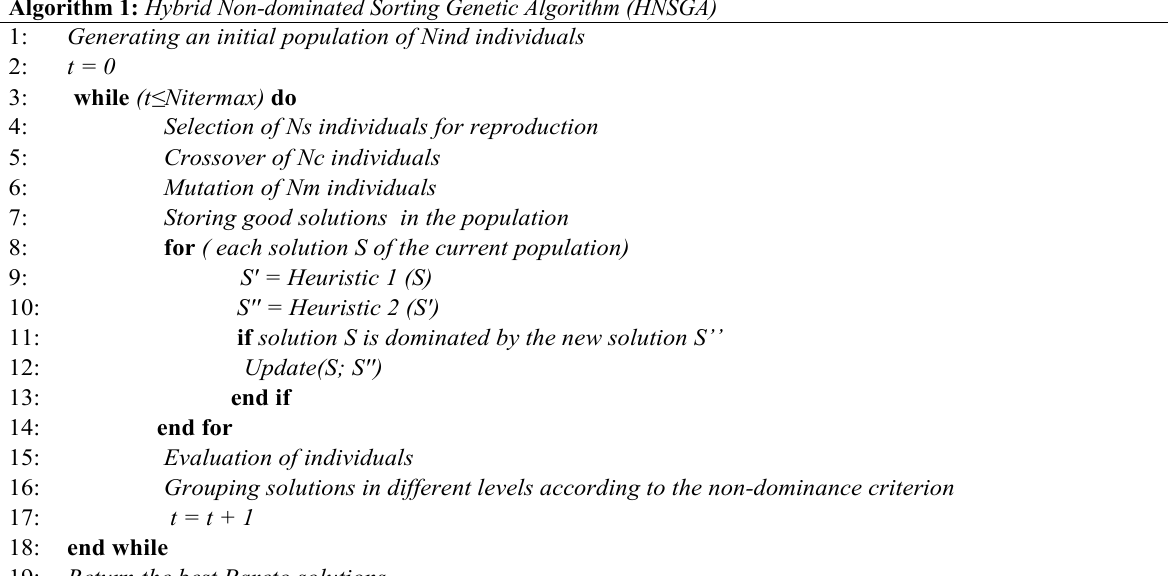
Algorithm 1: Hybrid Non-dominated Sorting Genetic Algorithm